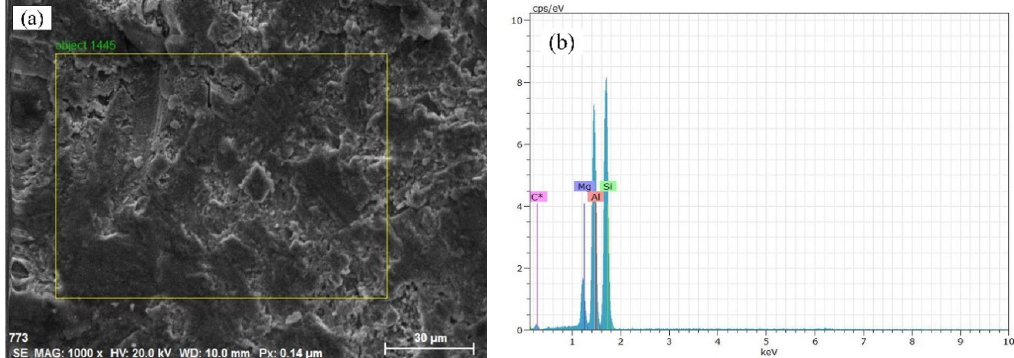
Figure 7. The energy spectrum analysis of the SiCp / Al composites; ( a ) Energy spectrum analysis block diagram; ( b ) SiCp / Al chemical compositions. Table 6. The chemical composition of the SiCp / Al composite.